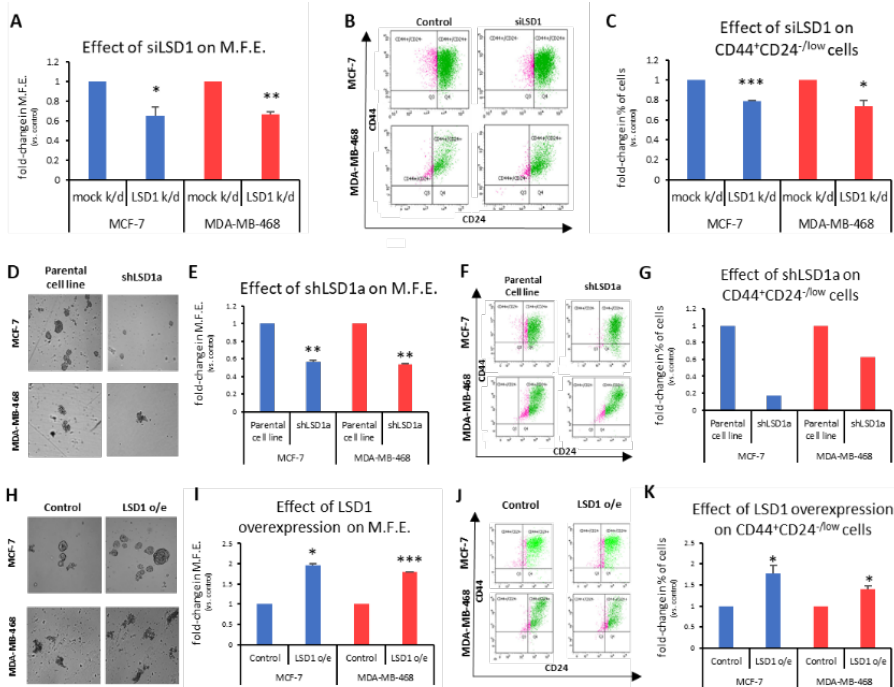
Figure 2. LSD1 regulates the stemness properties of bCSCs. ( A ) Graphical representation of the effects of LSD1 knock-down on the mammosphere forming efficiency (MFE) MCF-7 and MDA-MB-468 cells were transfected with siRNA against LSD1 and cultured under mammosphere-forming conditions for 7 days when the MFE was calculated. Cells transfected with scrambled siRNA served as the control. ( B ) FACS analysis for CD44 + CD24 -/low cells in MCF-7 and MDA-MB-468 mammospheres after siRNA-mediated LSD1 knock-down. ( C ) Quantification of FACS analysis presented in ( C ). ( D ) Representative images of MCF-7 and MDA-MB-468 mammospheres derived from parental and stable LSD1 knock-down cells after 7 days in culture. ( E ) Graphical representation of the effects of stable LSD1 knock-down on the MFE of MCF-7 and MDA-MB-468 mammospheres after 7 days in culture under mammosphere-forming conditions. Parental cell lines served as control. ( F ) FACS analysis for CD44 + CD24 -/low cells in MCF-7 and MDA-MB 468 mammospheres derived from parental and stable LSD1 knock-down cell lines. ( G ) Quantification of FACS analysis presented in ( F ). Data from one experiment performed in triplicate, pooled for FACS analysis, are shown. ( H ) Representative images of MCF-7 and MDA-MB-468 mammospheres derived from control and LSD1-overexpressing cells after 7 days in culture. ( I ) Graphic representation of the effects of LSD1 overexpression on the MFE of MCF-7 and MDA-MB-468 mammospheres. Cells transfected with empty vector served as control. ( J ) FACS analysis for CD44 + CD24 -/low cells in MCF-7 and MDA-MB-468 mammospheres after LSD1 overexpression. ( K ) Quantification of FACS analysis presented in ( I ). Error bars represent SEM. * p < 0.05, ** p < 0.01, *** p < 0.001.